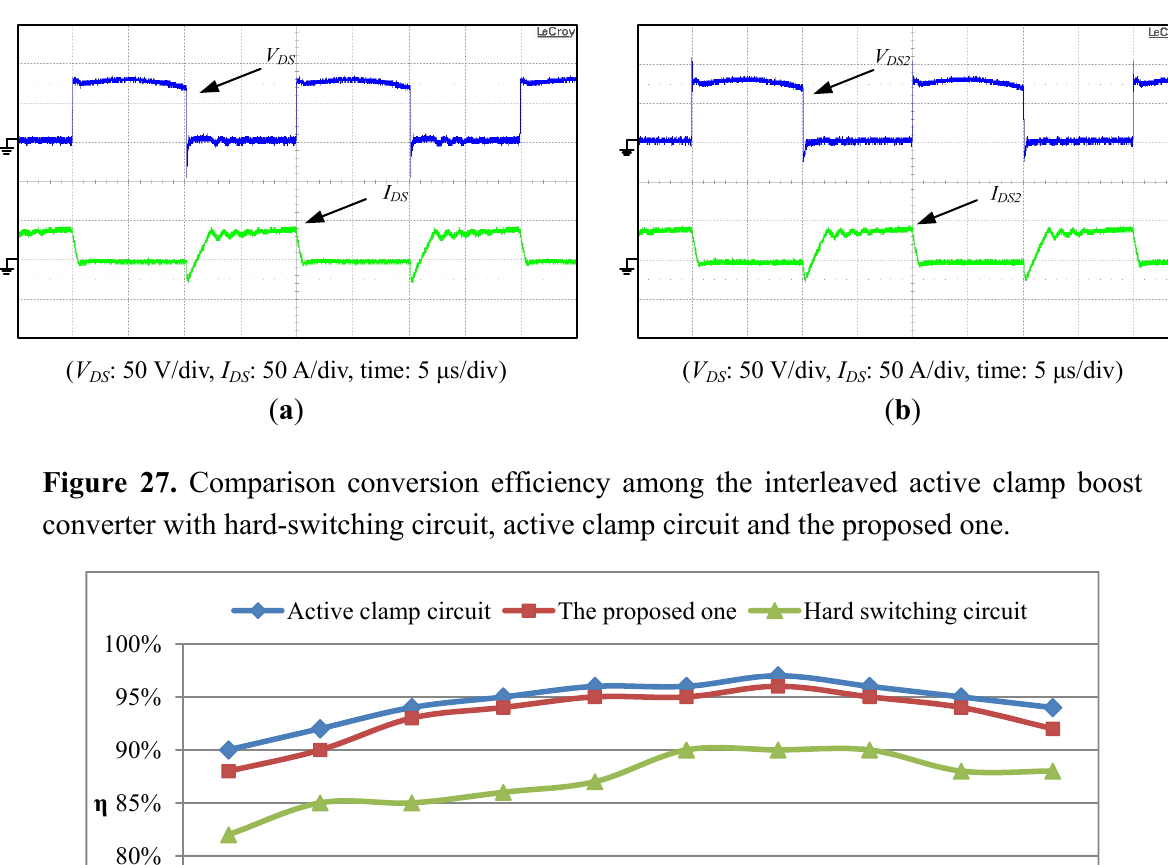
and current I waveforms of ( a ) switch M DS DS